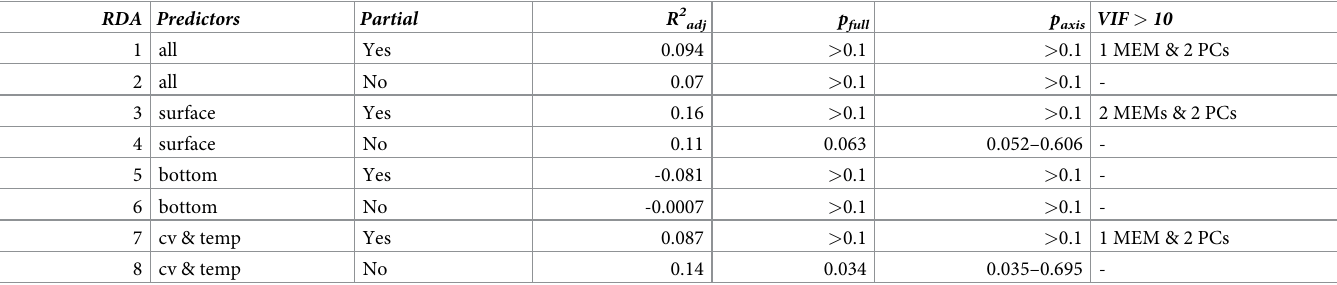
Table 7. Results of the redundancy analyses